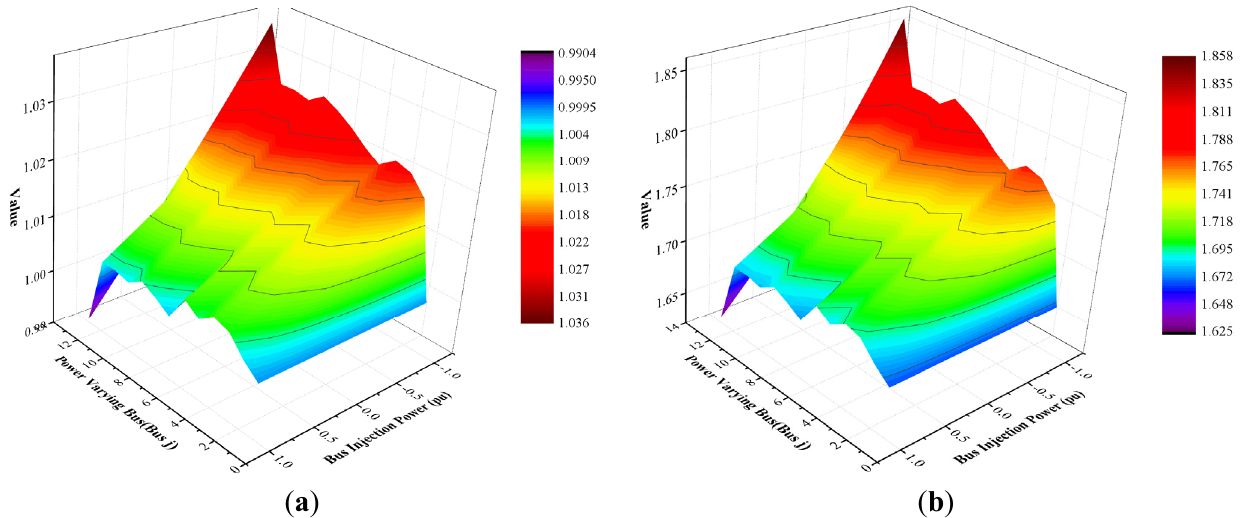
Figure 6. The results of Equation (37) as a function of the injected power at the bus.